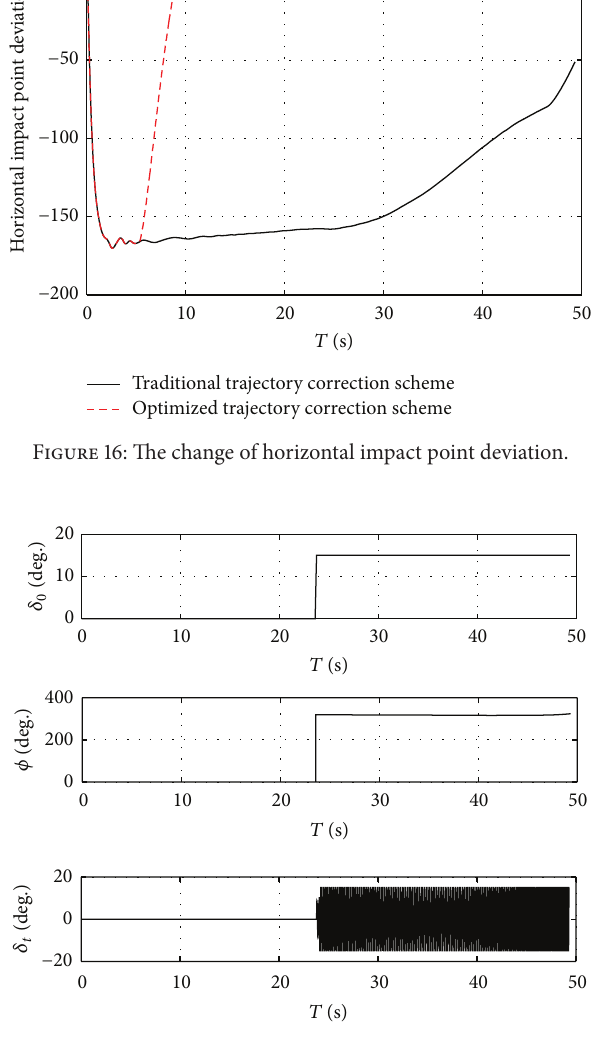
Figure 17: The deflection angle and control phase histories of the controlled trajectory with traditional trajectory correction scheme.